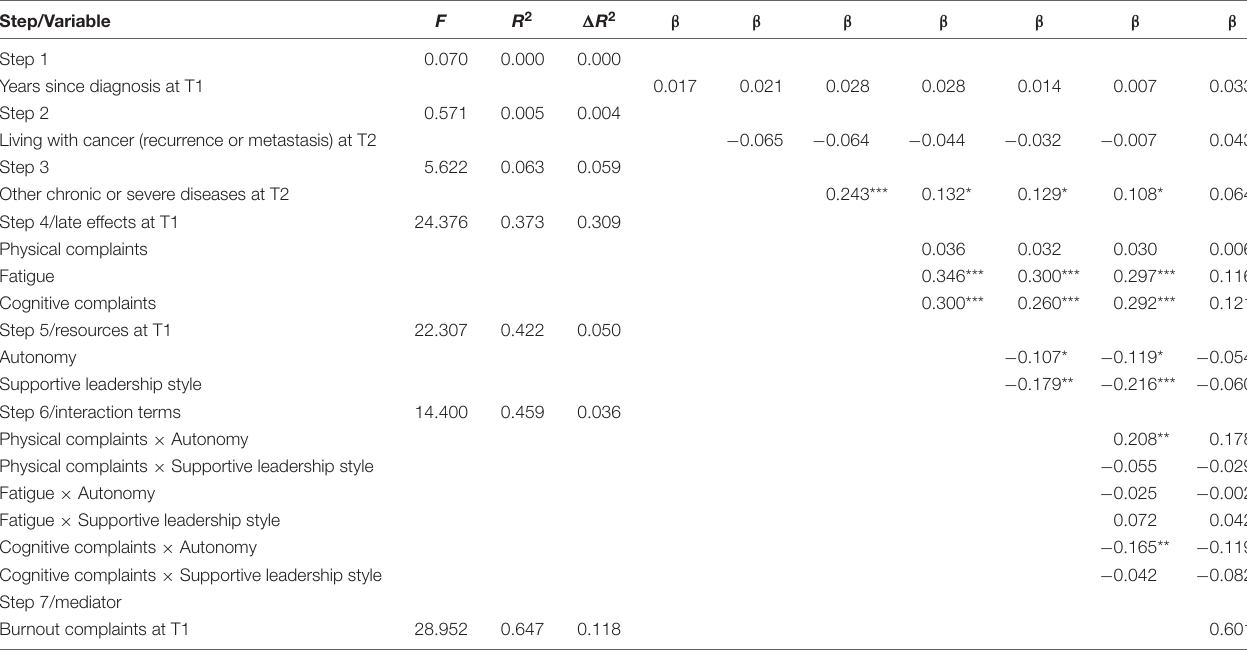
TABLE 3C | Multivariate regression analyses for moderation by autonomy or supportive leadership style (at T1) of the association of physical complaints, fatigue, or cognitive complaints (at T1) with future burnout complaints (at T2), controlled by years since diagnosis, living with cancer (recurrence or metastasis), other chronic or severe diseases and burnout complaints at